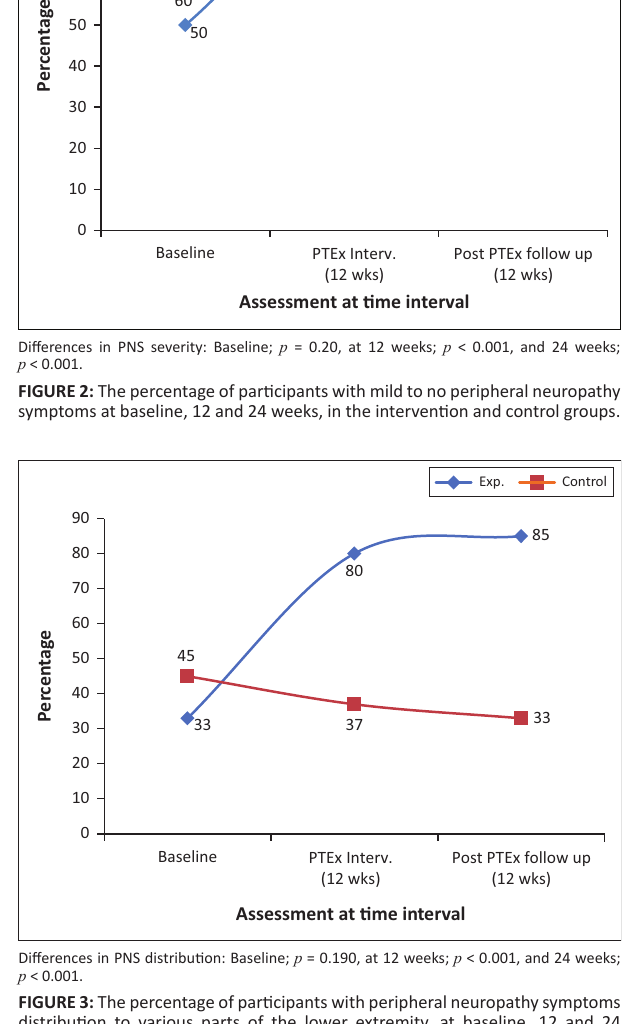
FIGURE 3: The percentage of participants with peripheral neuropathy symptoms distribution to various parts of the lower extremity, at baseline, 12 and 24 weeks, in the intervention and control